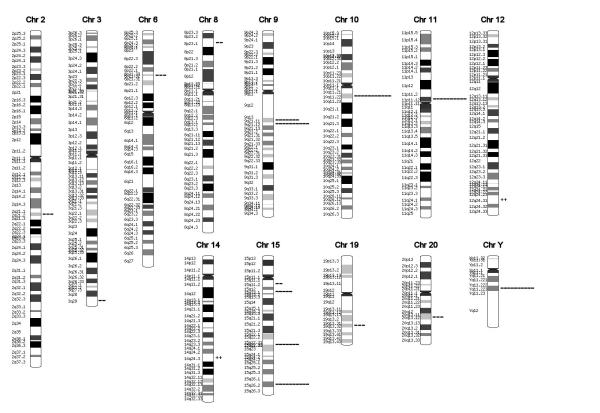
Cytoband mapping of ES cell expressed genes and regions of relatively high and low transcription relative to the refseq database is shown. More detailed mapping information is presented in supplementary tables.